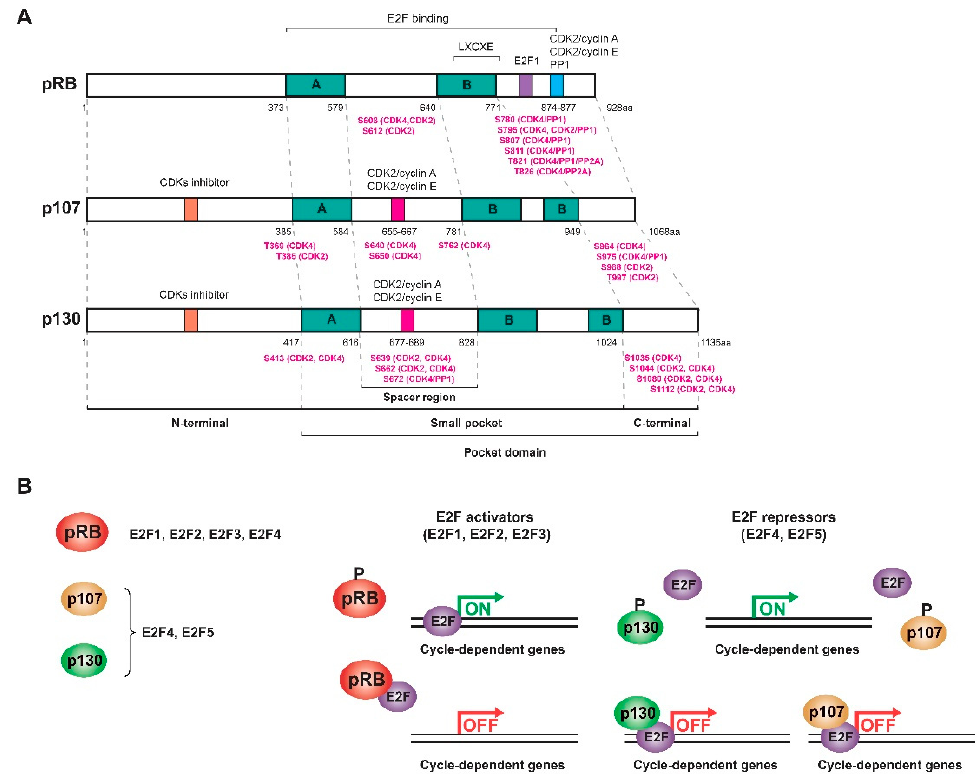
Figure 1. RB family proteins or pocket proteins. ( A ) Scheme of the structure of the three proteins of the RB family showing the different domains and motifs and the most relevant phosphorylated residues (highlighted in pink) with their respective kinases/phosphatases. ( B ) Interaction and regulation mechanisms of the pocket proteins with the different E2F transcription factors. Figure adapted from [19–21,39].